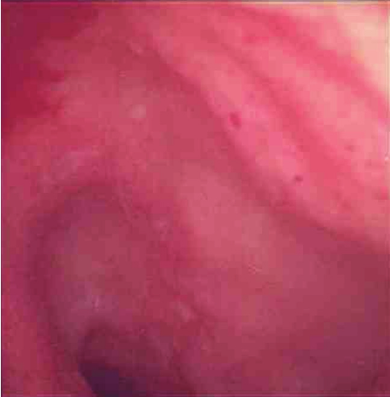
Figure 2: Multiple erosions in the terminal ileum seen at